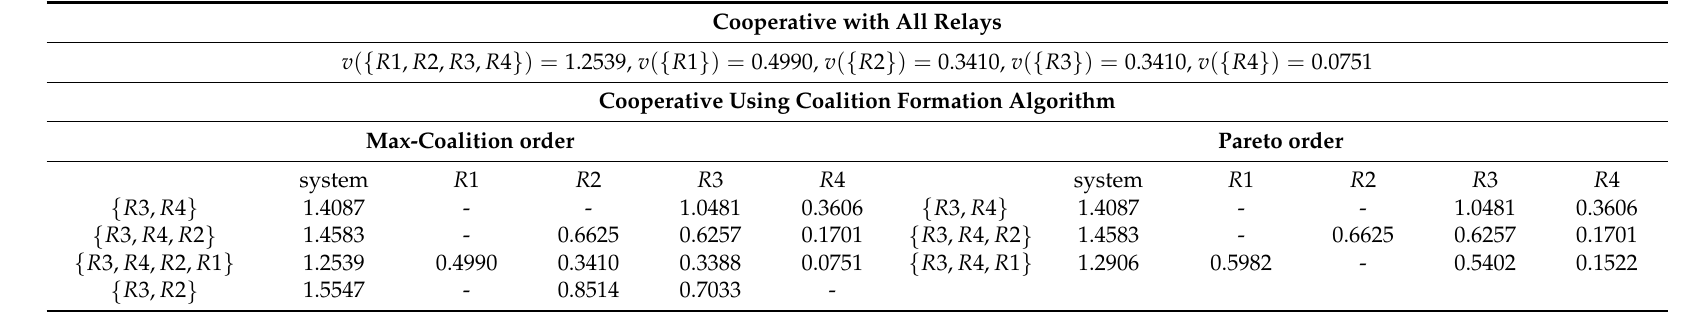
Table 2. The utility of each potential coalition and each relay for the network of Figure